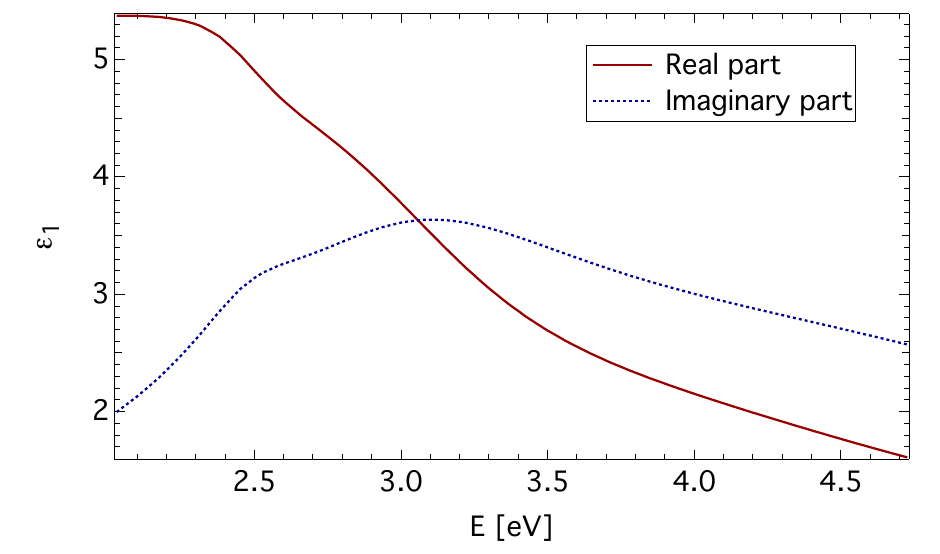
Figure 1. The diagonal element, ε film (Sample